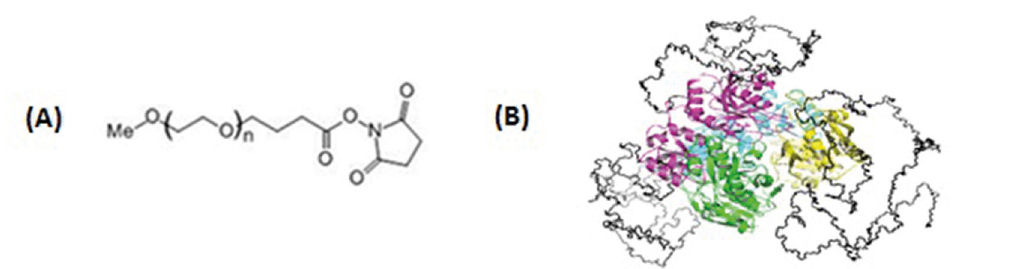
FIGURE 1 - (A) Chemical structure of N-terminal reactive PEG and (B) schematic representation of a tetrameric protein PEGylated with 10,000 Da PEG chains at the N -terminal